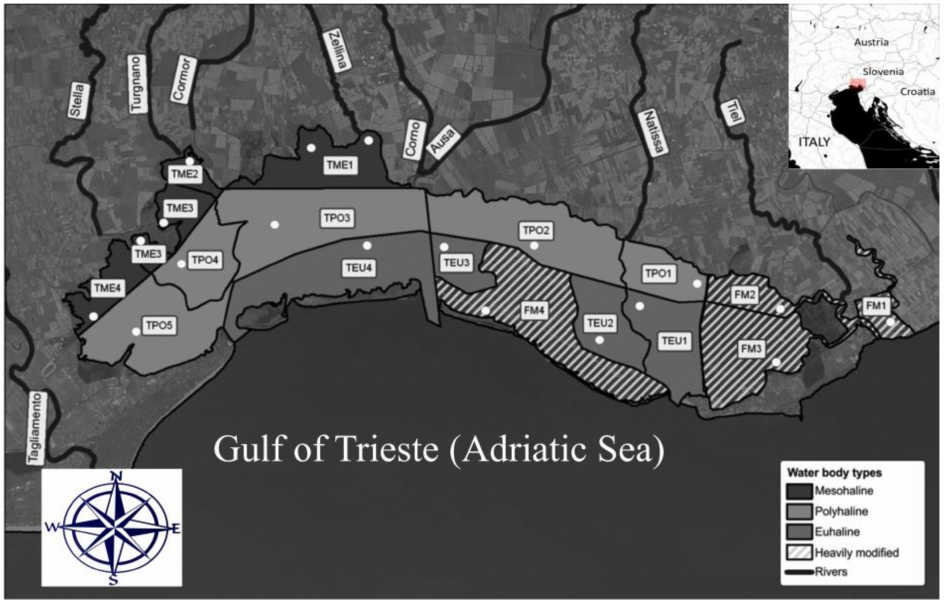
Figure 1. The Marano and Grado Lagoon with the monitored water bodies (WBs) defined sensu WFD/2000/60/CE